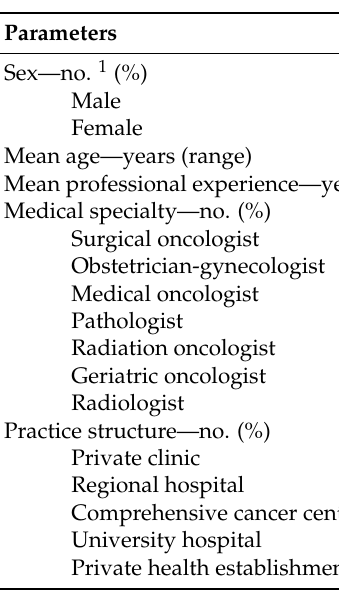
Table 1. Characteristics of survey